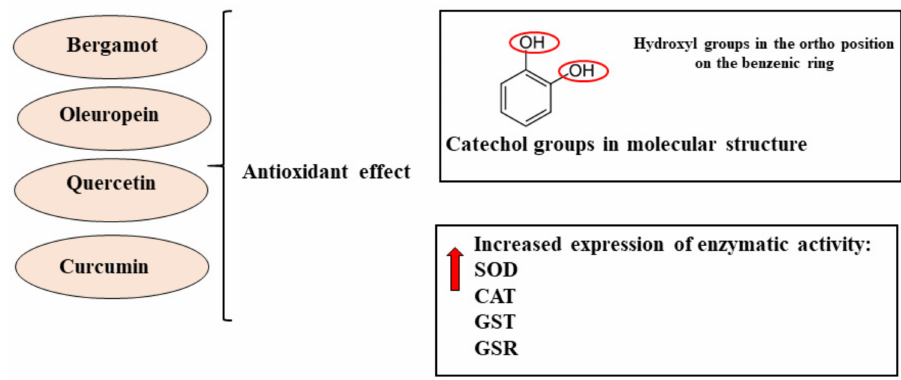
Figure 4. Antioxidant effects exerted by bergamot, oleuropein, quercetin and